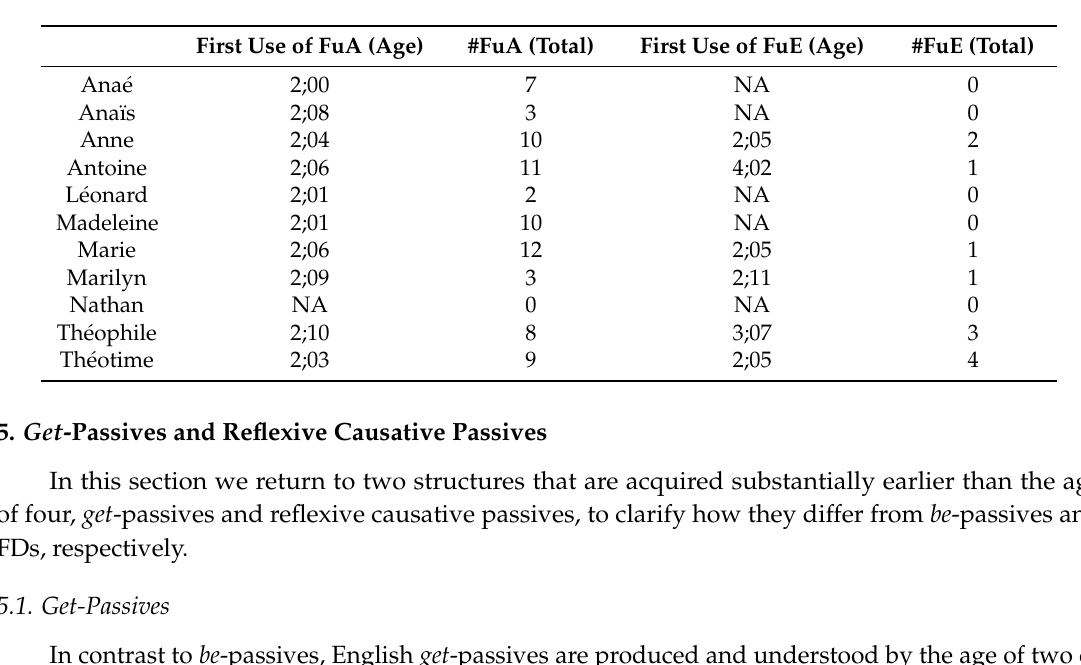
Table 3. Causativized intransitives, by